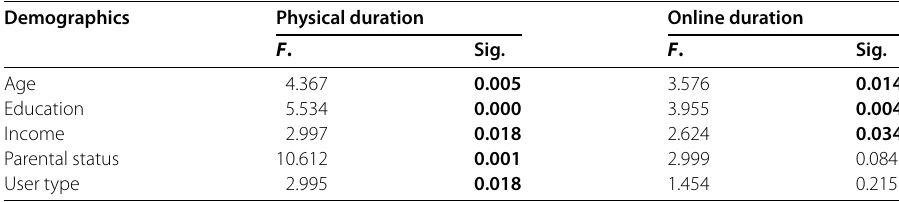
Table 5 ANOVA test on duration Demographics Physical duration Online duration F . Sig.